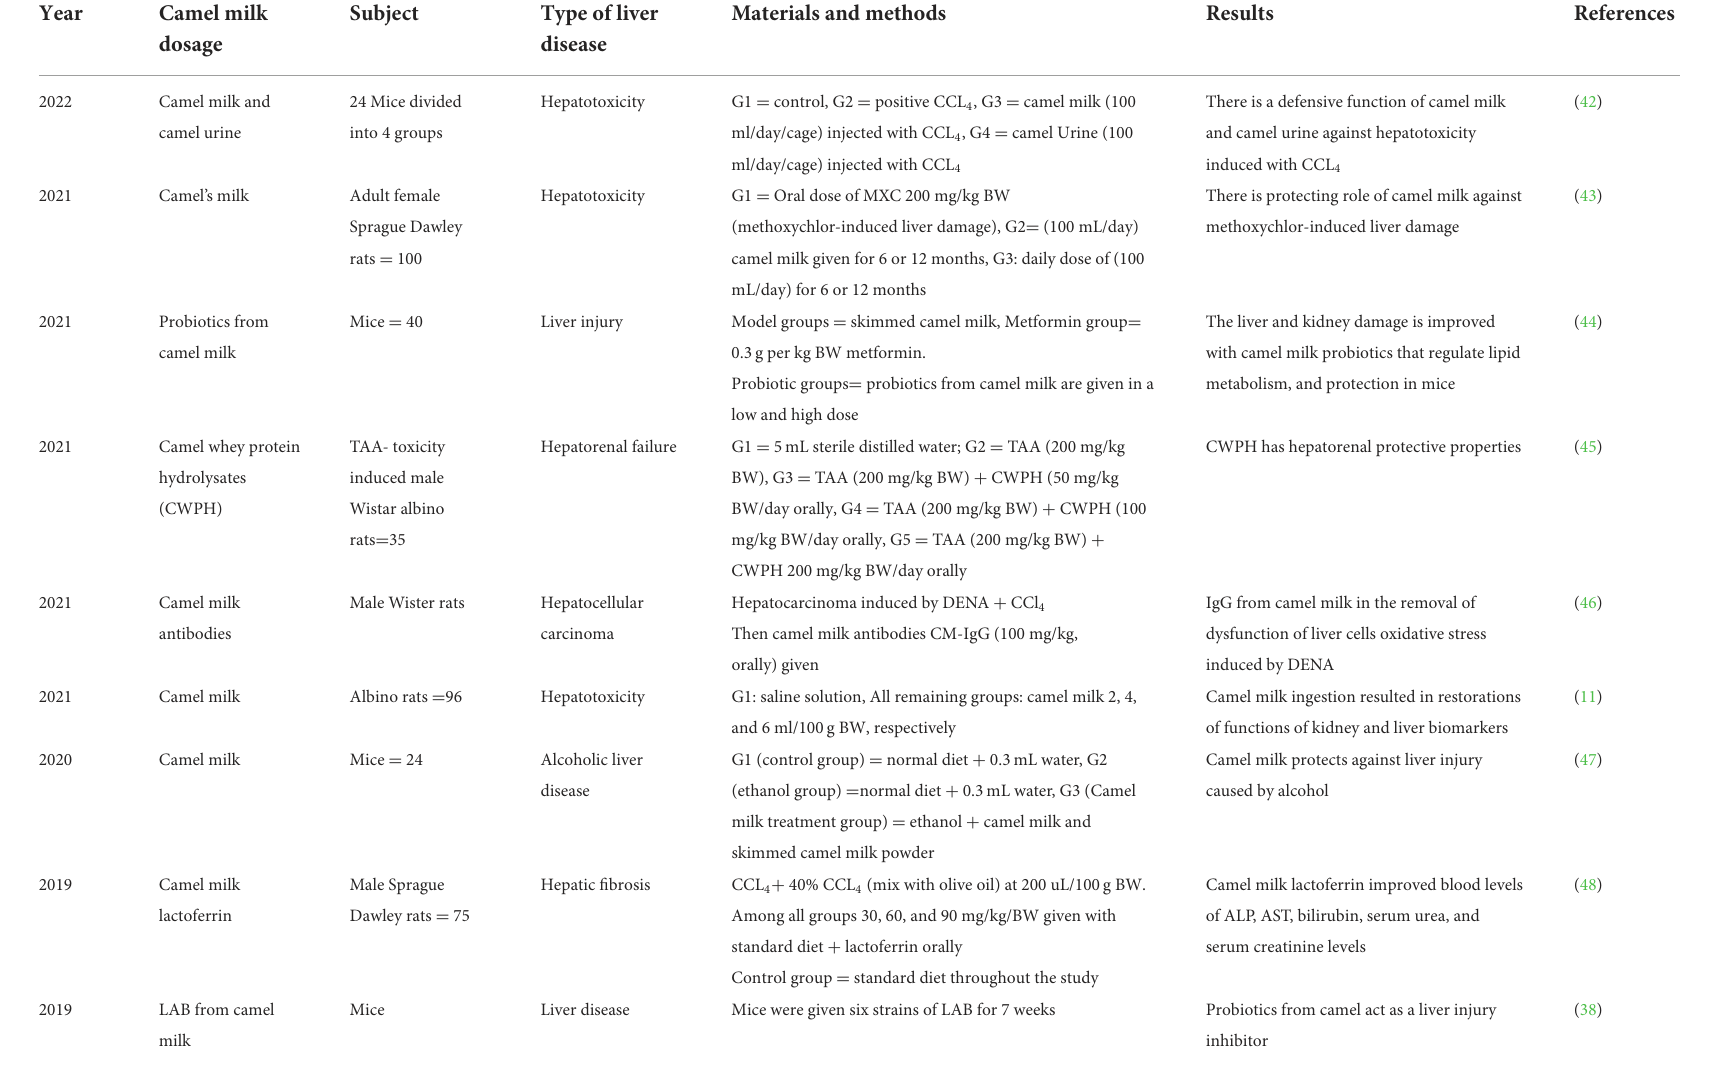
TABLE 3 Scientific studies explain the hepatoprotectiveness of camel